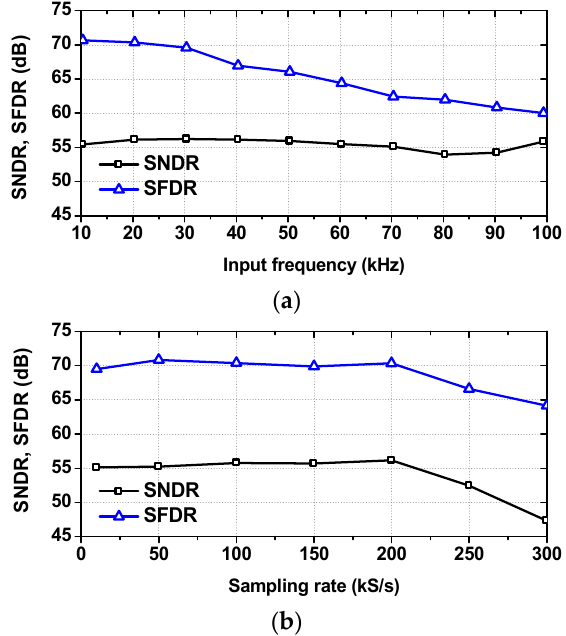
Figure 24. ( a ) Measured SNDR and SFDR at different input frequencies. f S = 200 kS/s, ( b ) Measured SNDR and SFDR at different sampling rates. f IN = 4.35 kHz.